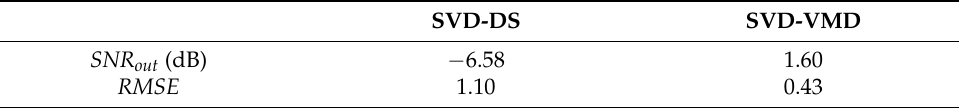
Figure 15. Time-domain waveform and frequency spectrum of the denoised signal using SVD-DS. Table 5. Comparison between SVD-DS and SVD-VMD for experimental signals.